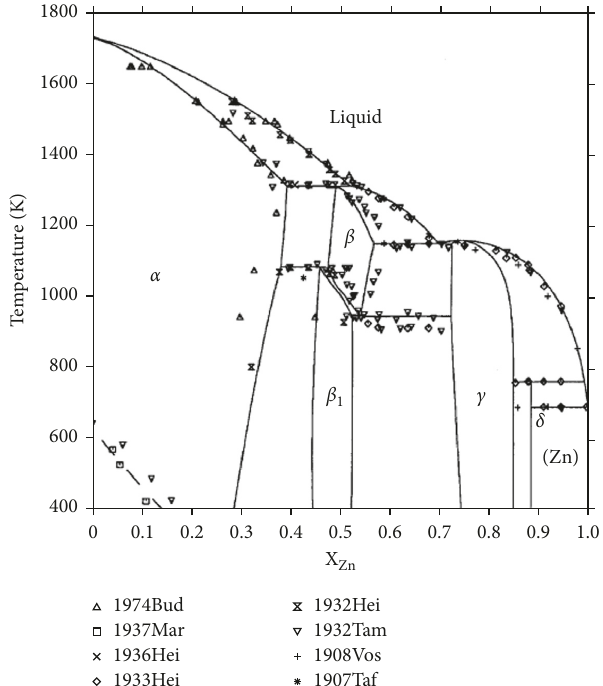
Figure 3: An equilibrium Ni-Zn phase diagram thermodynami- cally calculated by Su et al.